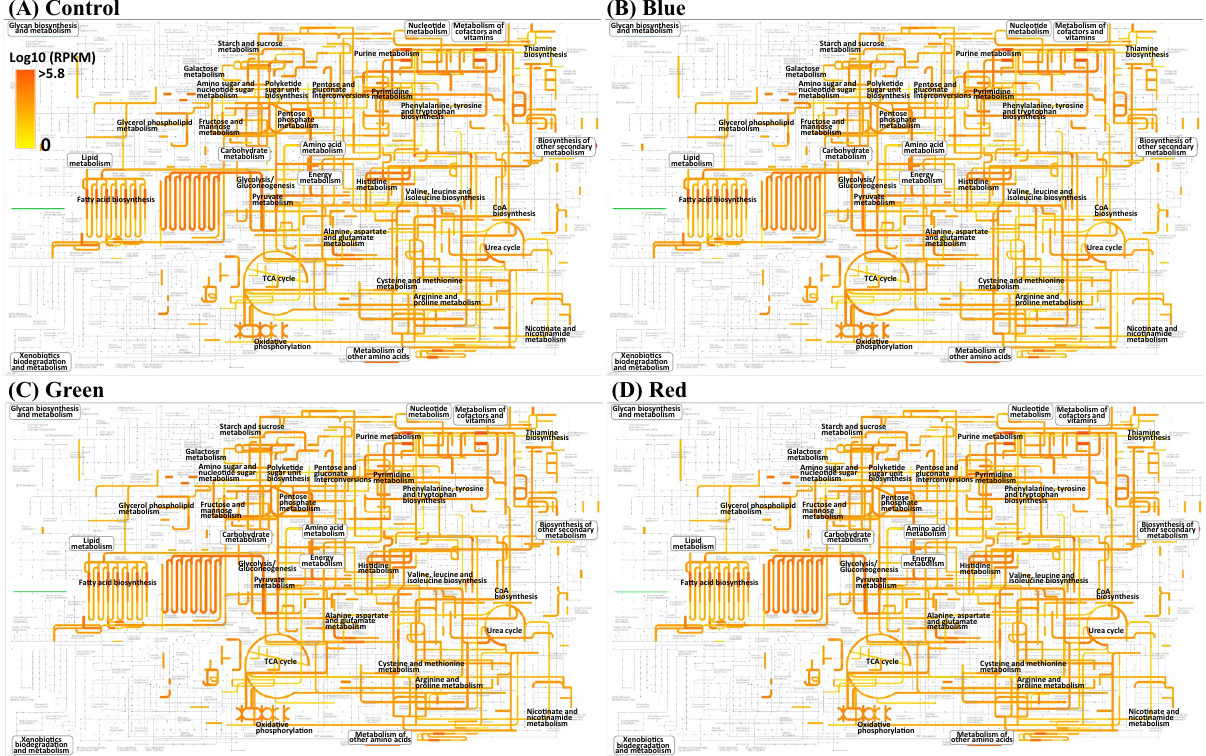
Figure 4. Transcriptional expression of the metabolic pathways of E. coli O157:H7 treated under different wavelength of lights. Cells growth under dark condition was served as control. The KEGG metabolic pathways were generated using the genome of strain E. coli O157:H7; their transcriptional expression levels are quantitatively depicted using line thickness and color changes, according to their read numbers per kilobase of each coding sequence, per million mapped reads (RPKM)